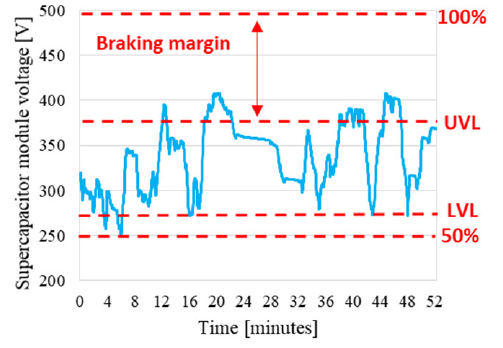
Figure 25. Extra-urban mission, supercapacitor SOC.